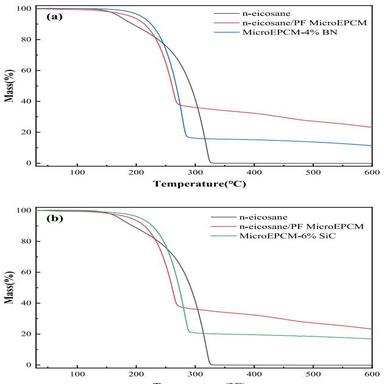
TG curves of (a) MicroEPCM-4%BN; (b) MicroEPCM-6%SiC.